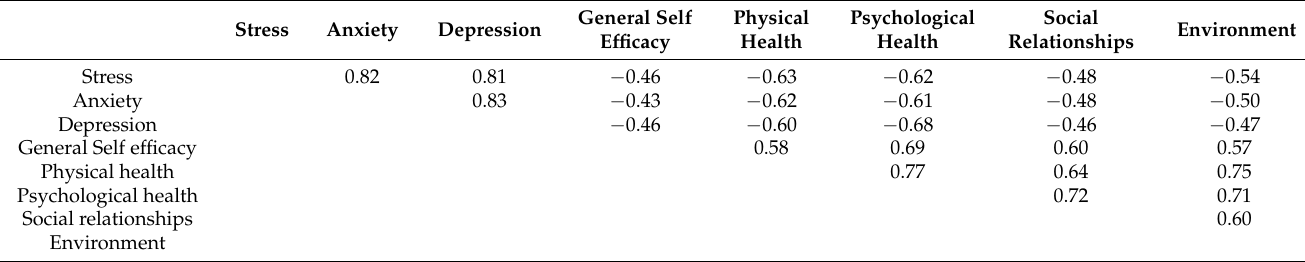
Table 3. Correlation table between emotional states, general self-efficacy, and the four domains of quality of